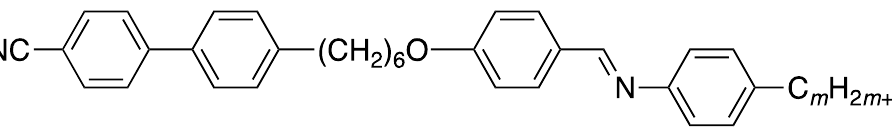
Figure 12. The shapes of the ( a ) trans and ( b ) cis isomers of CB6OABOBu.